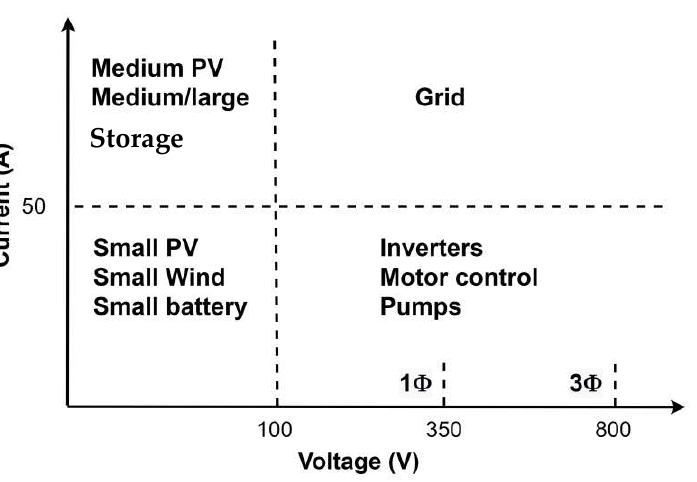
Figure 5. Common voltage ranges on power converters, depending on usage and size [15].